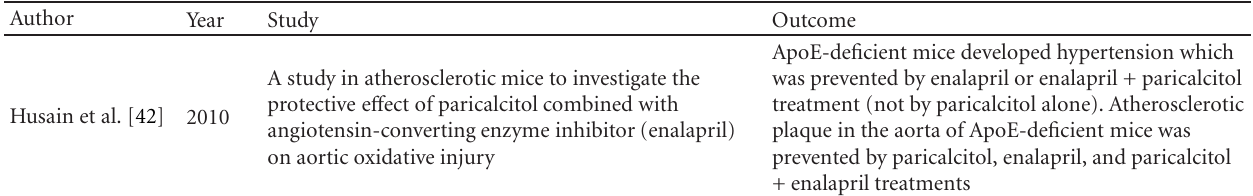
Table 9: Prevention of